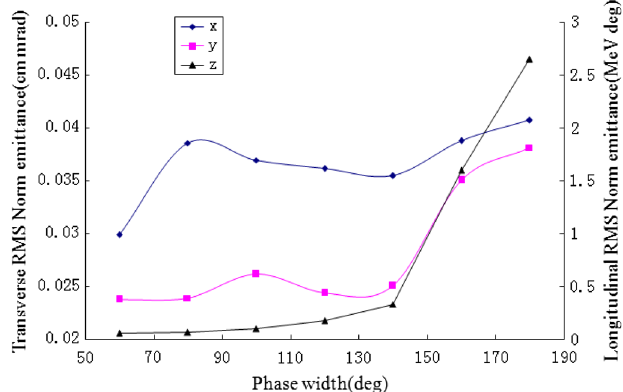
FIG. 19. Transmission as a function of transverse beam ellipse